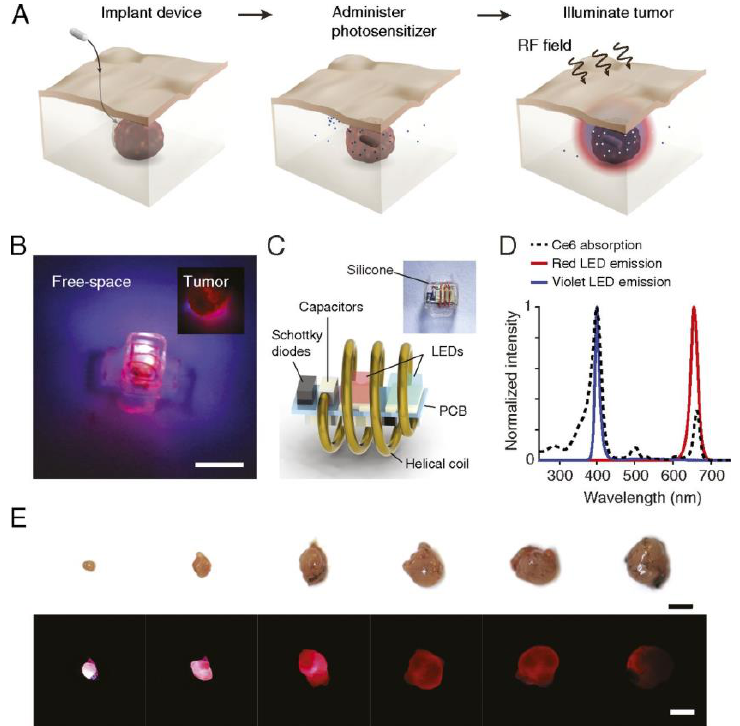
Figure 10. Wireless photonic PDT. ( A ) Schematic of the therapy. The therapy consists of implantation of wireless LED near the target region, administration of the PS, and wireless powering of the device. Light emitted by the device locally activates the PSs and induces tumour damage. ( B ) Image of the wireless photonic device emitting light. (Inset) The device illuminating an explanted tumour. (scale bar, 2 mm.) ( C ) Schematic of the device and individual electronic components. ( D ) The optical emission spectrum of the device from two LEDs. The emission wavelengths are centred at 400 nm (violet) and 660 nm (red), overlapping with the absorption peaks in the Ce6 spectrum. ( E ) Image panel of the penetration of light emitted by the device (radiant power, 1.3 mW) through tumours of increasing volume (scale bar, 5 mm). Reproduced from A. Bansal et al. PNAS; published by National Academy of Sciences under CC BY-NC-ND or CC BY license, 2018 [242].